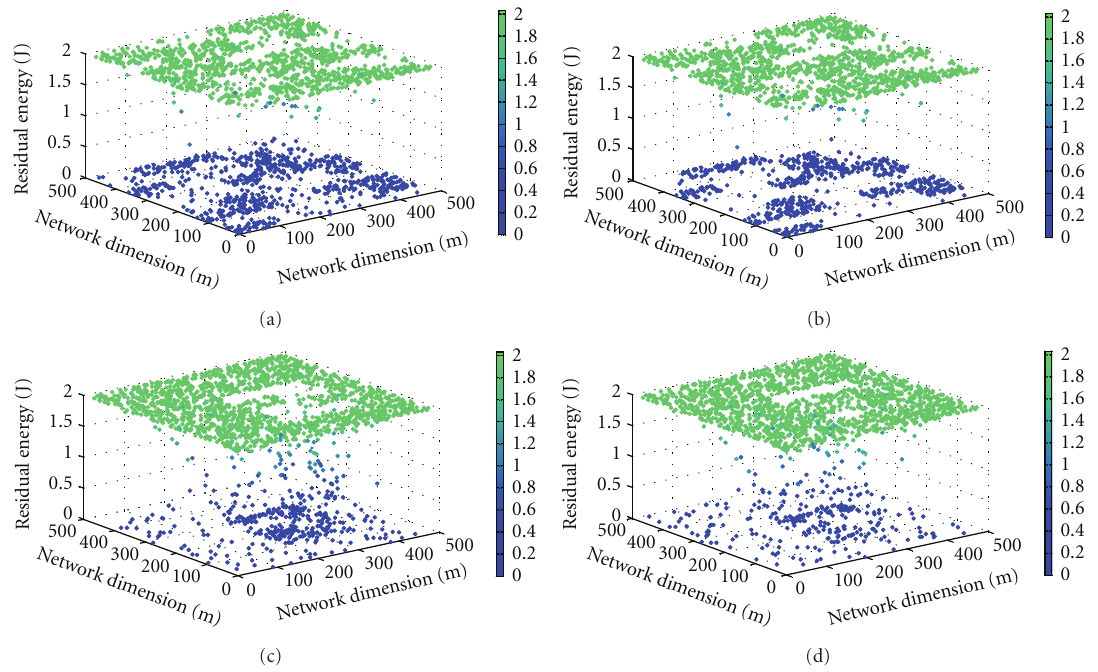
Figure 17: The obtained results after receiving 5000 frames at the base station with QCIF Akiyo video in case of not having channel error: (a) MPEG-2/H.262 scheme, (b) Magli scheme [20], (c) the proposed scheme 1, and (d) the proposed scheme 2.